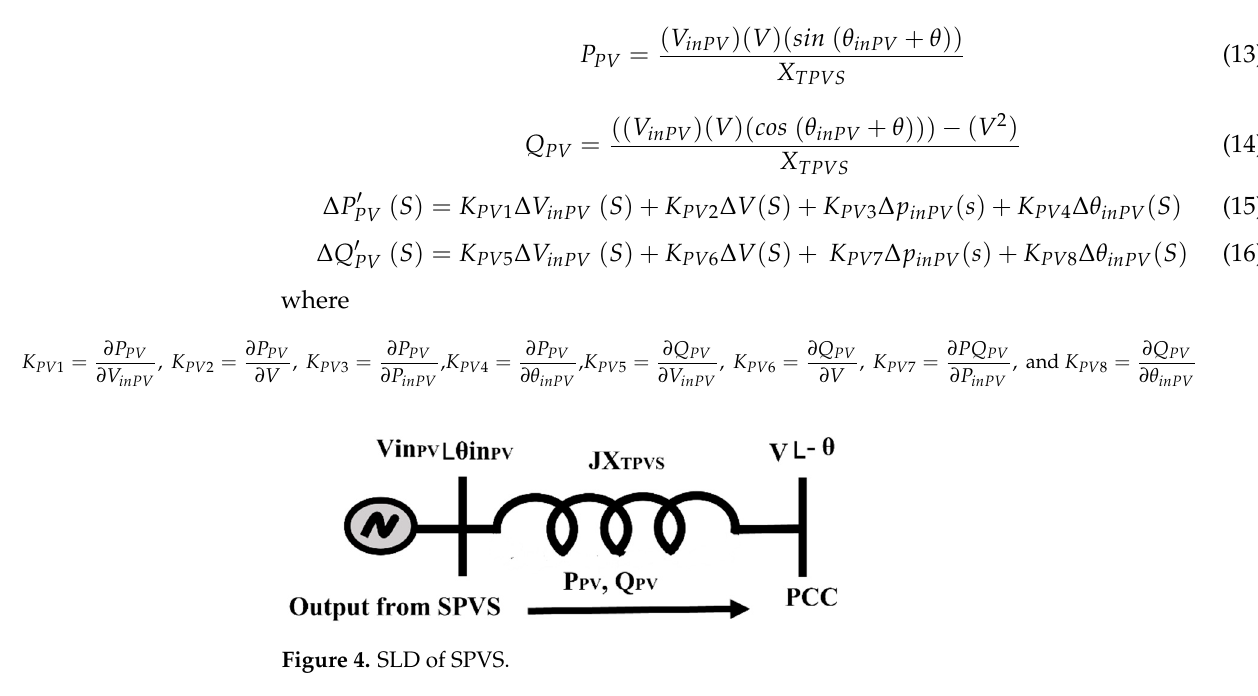
Figure 4. SLD of Figure 4. SLD of SPVS.